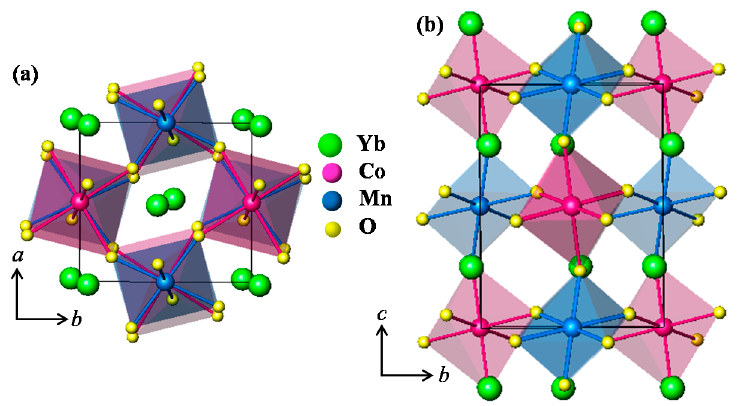
Figure 3. Views of the crystallographic structure of YCMO from the c axis ( a ) and the a axis ( b ). Green, red, blue and yellow spheres represent Yb 3+ , Co 2+ , Mn 4+ , and O 2 − ions, respectively. The black box with the cross-section rectangles designates the crystallographic unit cell.